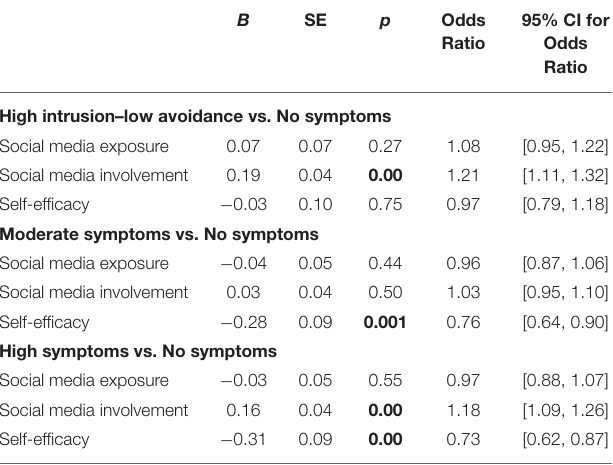
TABLE 3 | Multinomial logistic regression modeling results of four profiles ( N =